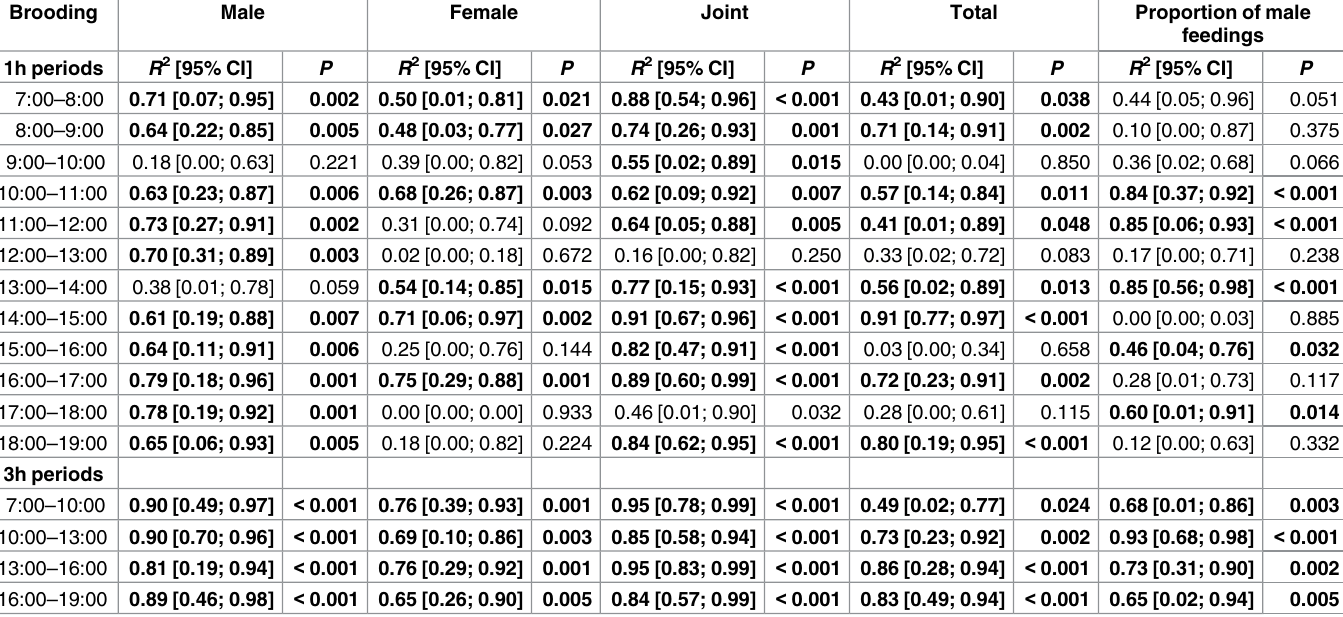
Proportion of variance explained( R 2 ) with 95% confidence interval estimated from bootstrapping and statistical significance of the relationship between parental effort in the given period and during the full day are given. Significant relationships are highlighted in